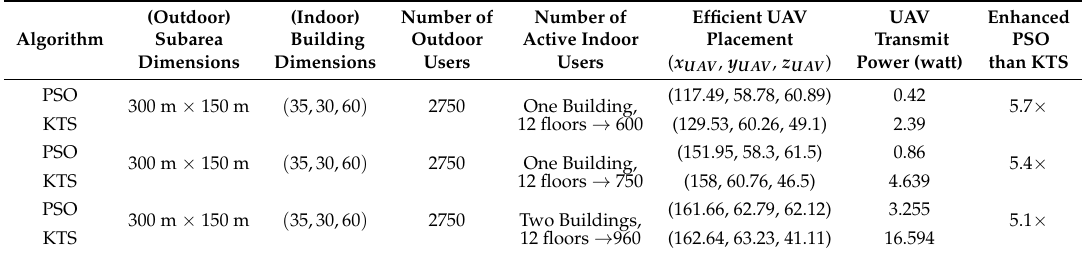
Table 3. Simulation results for providing wireless coverage using a single UAV for outdoor and indoor receivers. KTS, K-means with Ternary